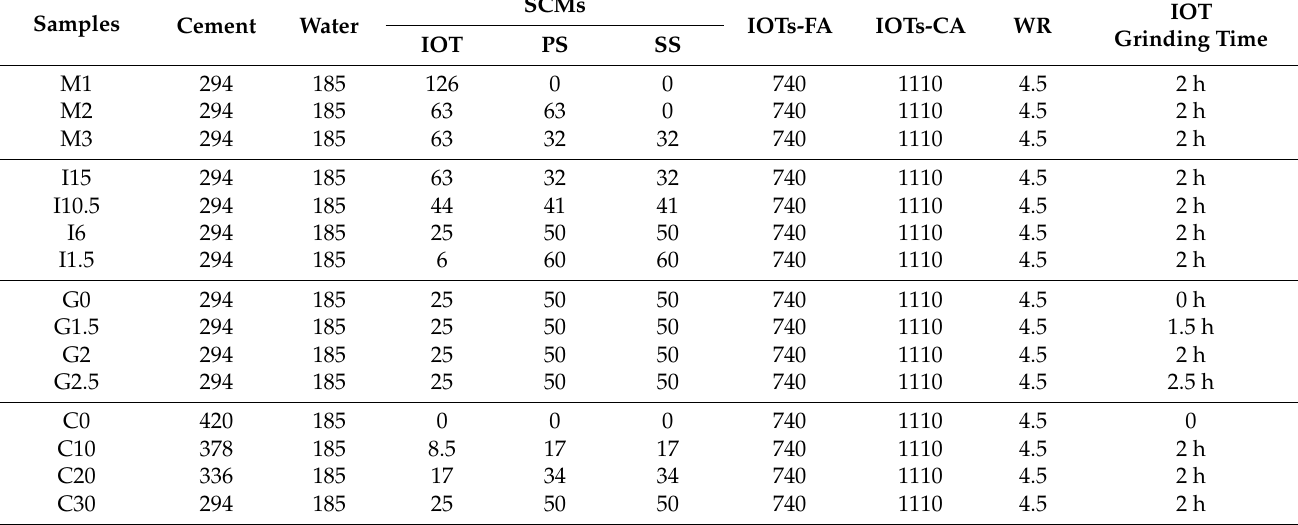
Table 2. Mix proportions of concretes (kg/m 3